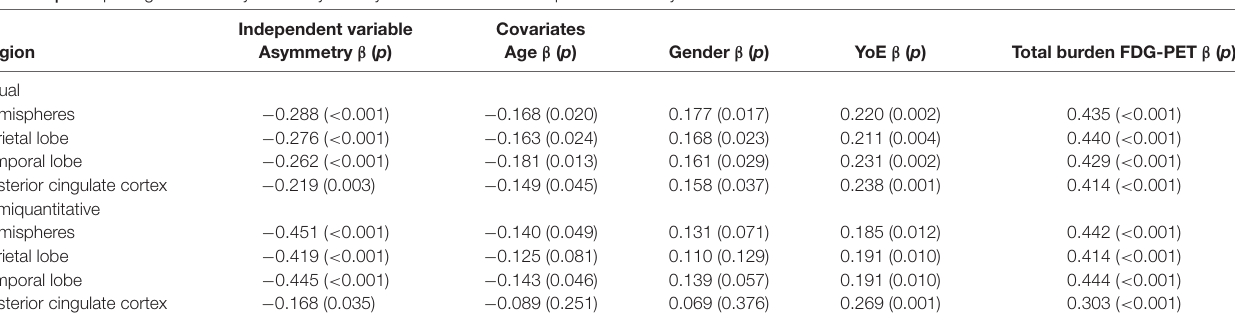
TABLE 3 | Multiple regression analysis for asymmetry in the visual and semiquantitative analysis based on total CERAD